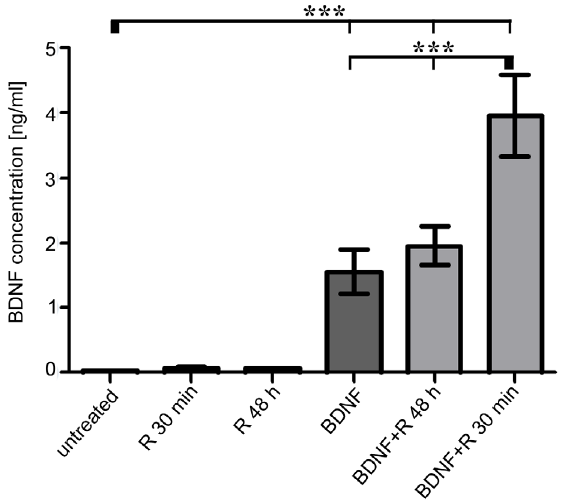
Figure 4. BDNF release from spiral ganglion cells is increased after co-treatment with Rolipram and BDNF. The concentration of released BDNF from spiral ganglion cells after treatment with Rolipram (R; 48 h and 30 min), BDNF (48 h) or both substances (BDNF 47R 30 min) was measured by ELISA. The supernatant of cells treated with BDNF alone or in combination with Rolipram contained significant higher concentrations of BDNF in comparison to supernatants from untreated cultures or from cells treated only with Rolipram. Application of Rolipram for 30 min to BDNF pre-treated cells resulted in a strong increase of BDNF in the supernatant. All values are given as mean 6 SEM. N=3; n=3 except for the untreated and Rolipram 48 h group: N=2, n=3; One-way ANOVA with Tukey’s multiple post hoc test was used to compare means: *p=0.05; **p=0.01; ***p=0.001. Reference of the significance is marked by the thick bar. N gives the number of independent approaches; n gives the number of samples per approach.